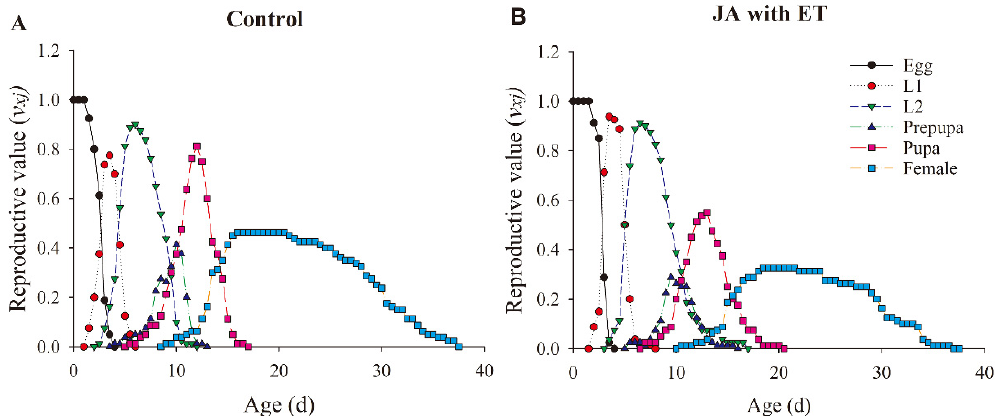
Figure 9. Effect of the JA with ET treatment on the age-stage-specific reproduction value ( v xj ) of Frankliniella occidentalis grown on faba bean plants . ( A ) Control group; ( B ) JA with ET group.